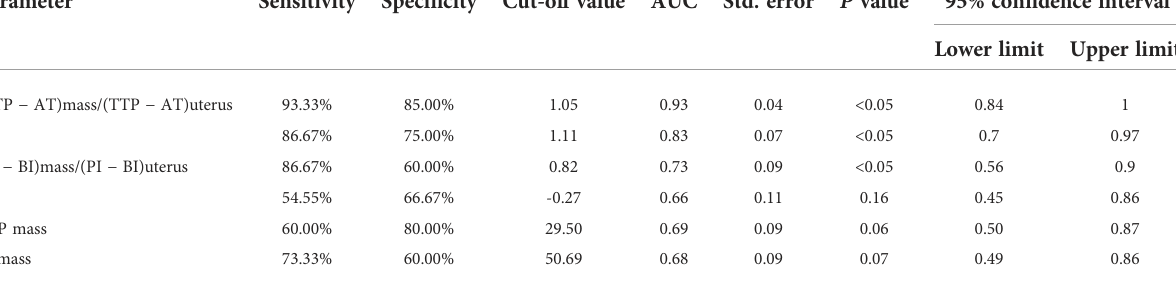
TABLE 4 ROC curve analysis of the predicted probability of CEU parameters for evaluation of benign and malignant adnexal mass. Parameter